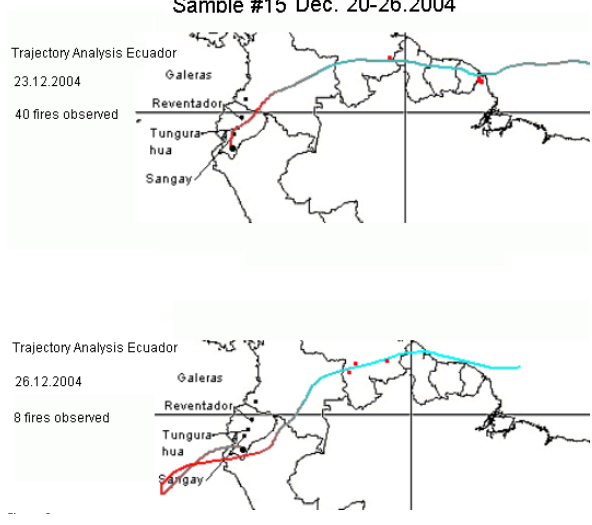
Figure 8: Fig. 8. 10-days back trajectories for sample #15 (see text for further